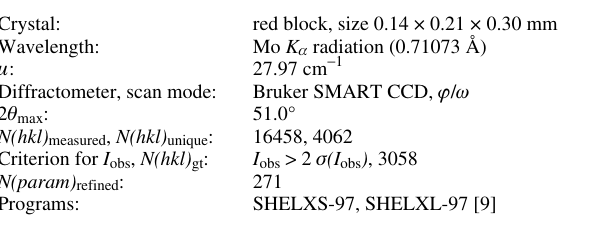
Table 1. Data collection and handling.